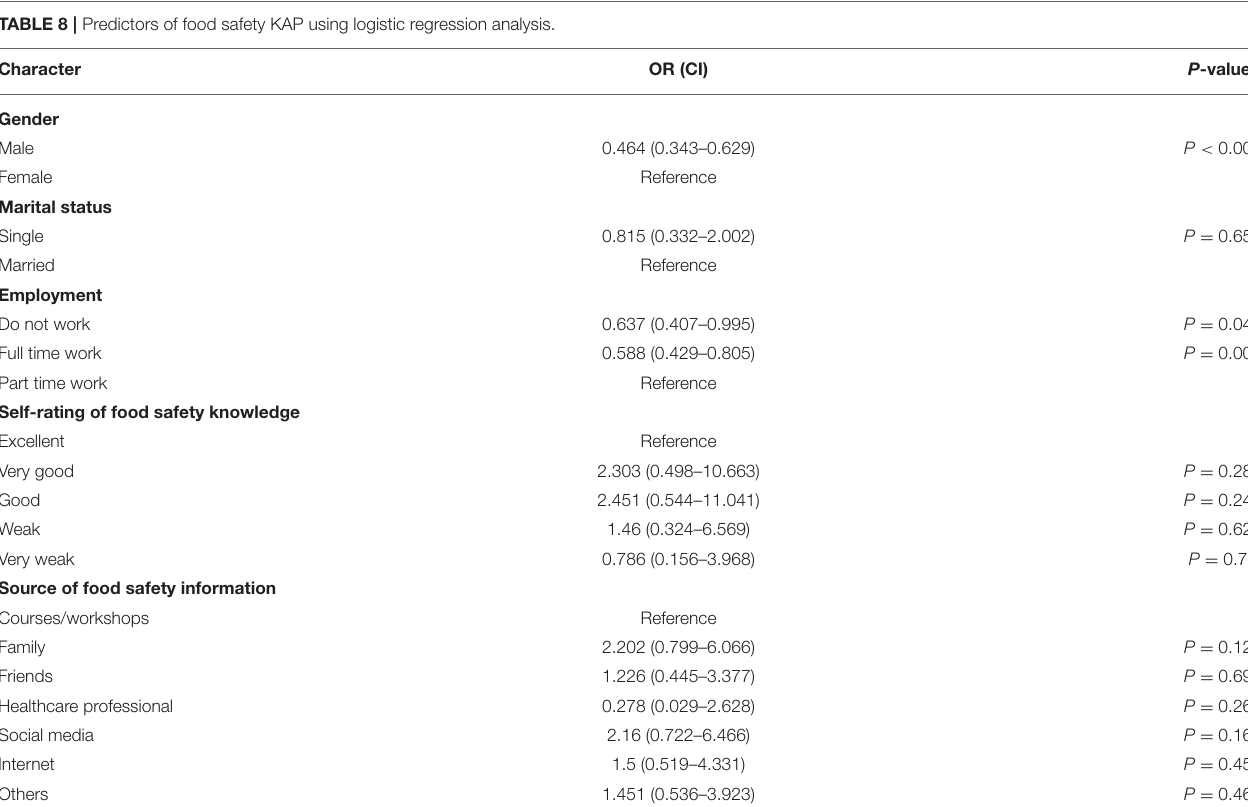
TABLE 8 | Predictors of food safety KAP using logistic regression